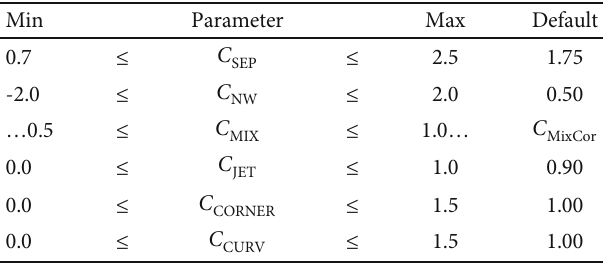
Table 1: Model coe ffi cients used in the GEKO model.